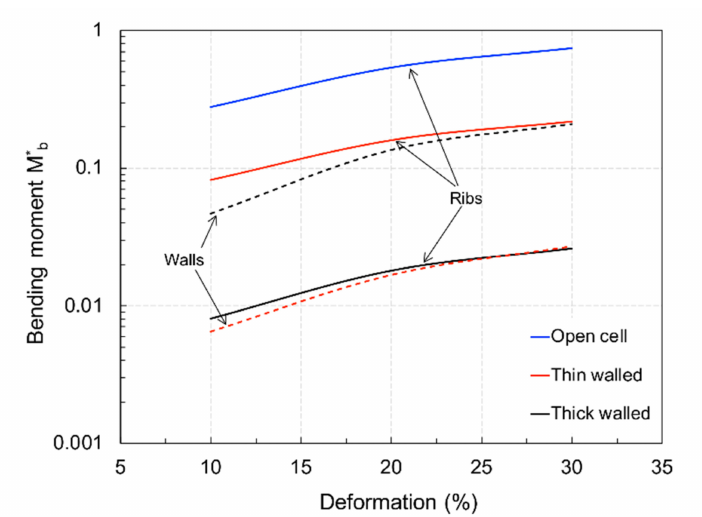
Figure 15. Comparison of bending load in the ribs and walls of the